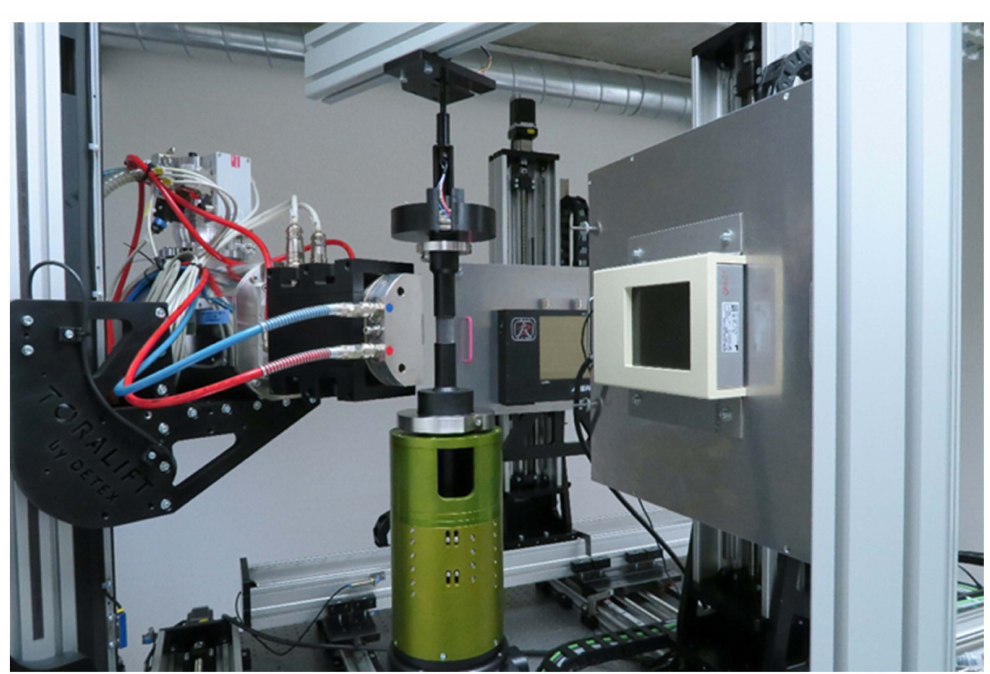
Figure 3. Experimental setup comprising the in-situ loading device mounted into